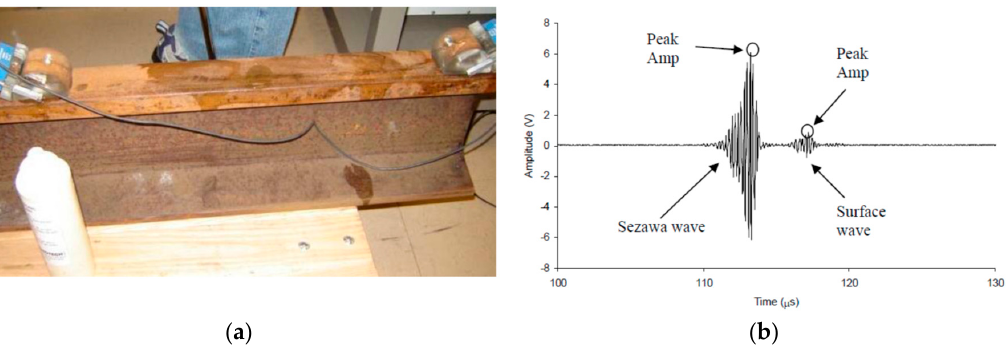
Figure 4. ( a ) Installation of angled beam piezoelectric transducers on a rail specimen. ( b ) Sezawa wave was greater in amplitude and arrives first (faster) than a surface wave [50].